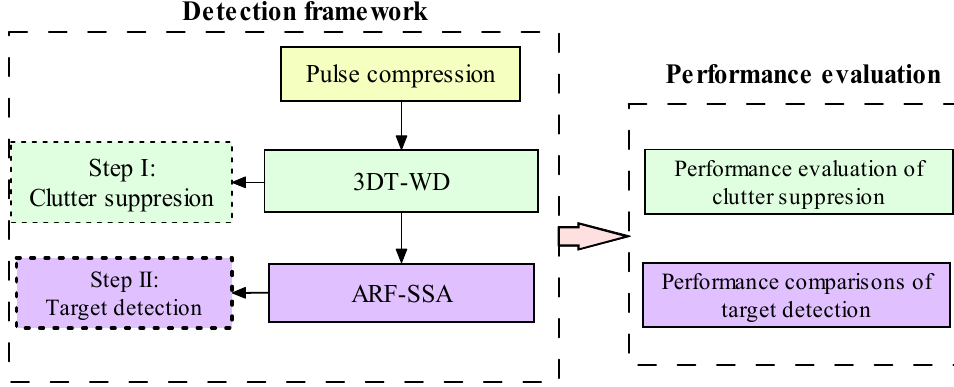
Figure 1. An overview of the proposed method architecture.